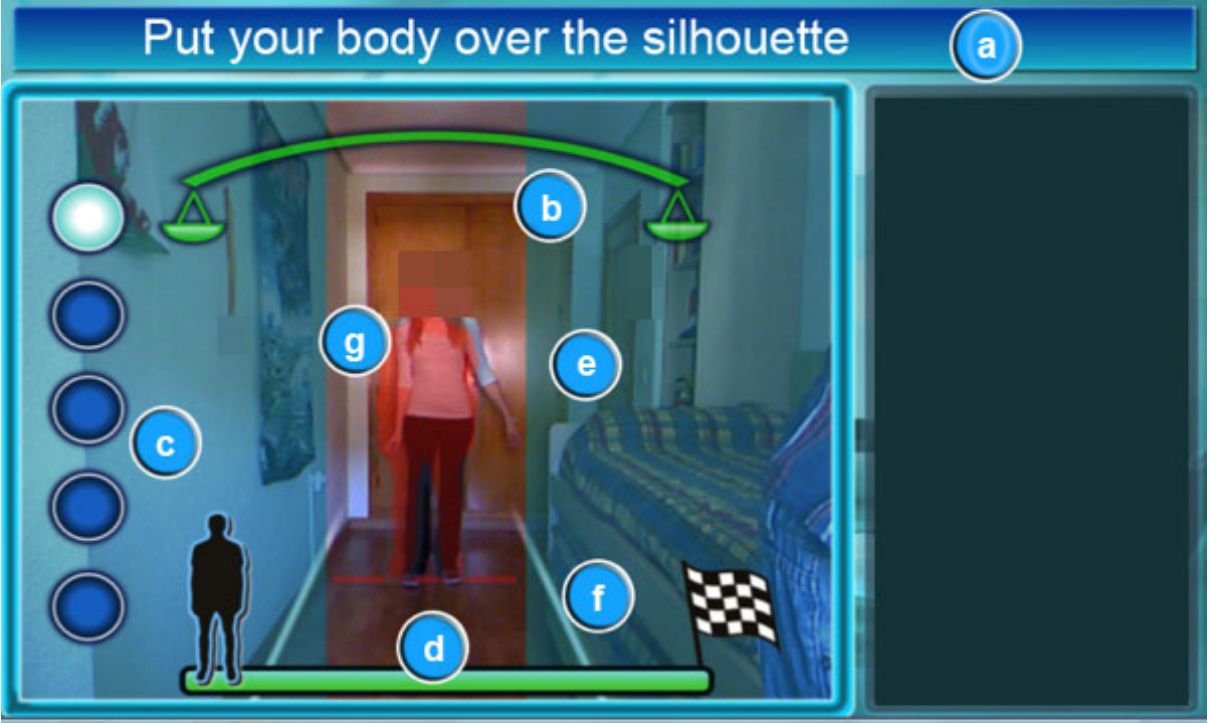
Figure 6. System screenshot which shows user instructions in order to complete the rehabilitation exercise. The interface elements in the screenshot